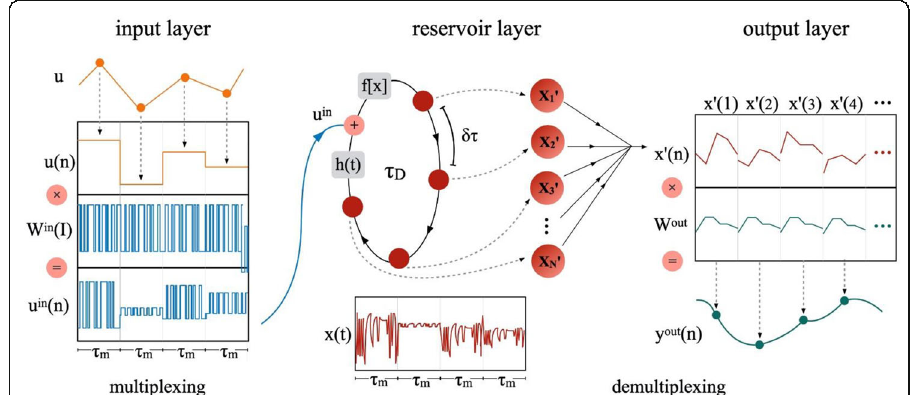
Fig. 4 Schematic illustration of the time-delay reservoir computer [114]. The input layer is implemented by modulating input u ( n ) with temporal mask to create input u in ( t ). τ m denotes mask duration, τ D denotes the duration of the delay in the feedback loop, δτ denotes the temporal separation or distance of virtual nodes. The reservoir state is detected during one